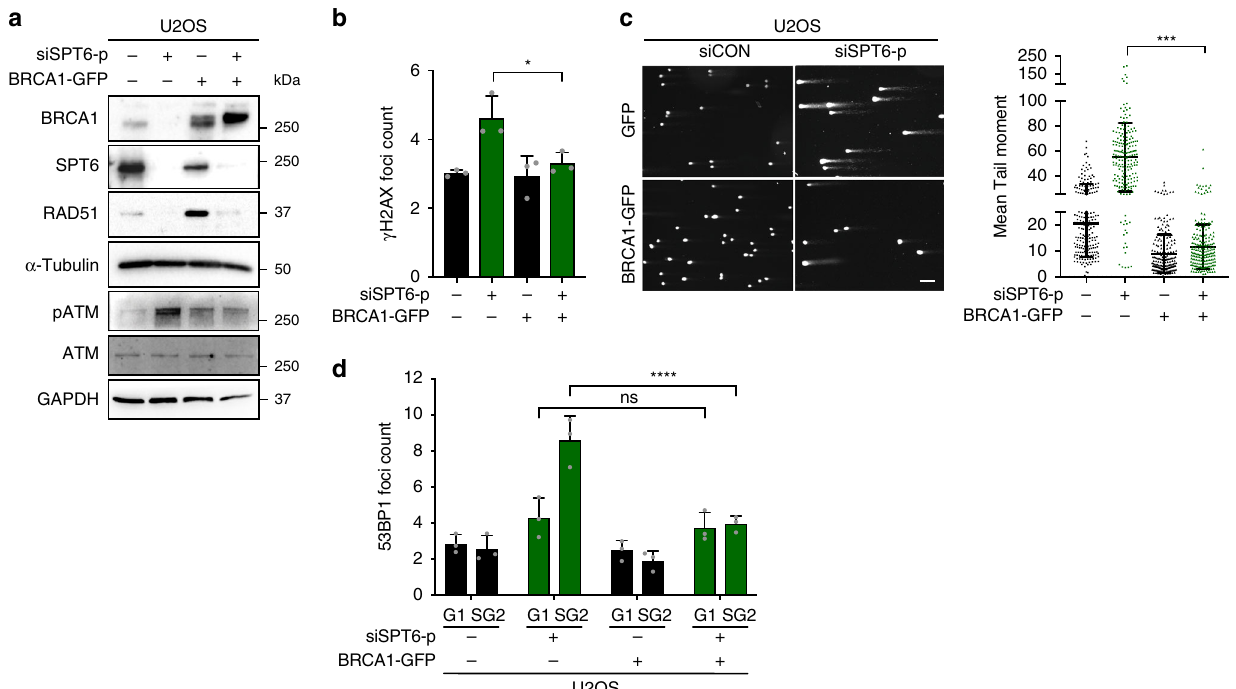
Fig. 6 Ectopic BRCA1 expression rescues SPT6 loss phenotype. a Representative immunoblot analysis of BRCA1, SPT6, RAD51, total and phosphorylated ATM expression in U2OS-GFP and U2OS-BRCA1-GFP cells transfected with siCON or siSPT6-p (pool). Loading control: α -Tubulin and GAPDH. b γ H2AX foci quanti fi cation in U2OS-GFP and U2OS-BRCA1-GFP cells transfected with either siCON or siSPT6-p. Data are presented as mean±s.d. * p = 0.0331; one-way ANOVA followed by Tukey ’ s multiple comparison test. c Representative DSBs quanti fi cation using comet assay. Data are presented as mean ±s.d. **** p < 0.0001; one-way ANOVA followed by Tukey ’ s multiple comparison test. Representative images are shown on left. d 53BP1 foci quanti fi cation in G1 and S/G2 phase U2OS-GFP and U2OS BRCA1-GFP cells transfected with siCON or siSPT6-p. Non-signi fi cant ns = 0.8471 and **** p < 0.0001; two-way ANOVA followed by Tukey ’ s multiple comparison test. N = 3 biologically independent experiments in ( a – d ). Source data are provided as a Source data fi